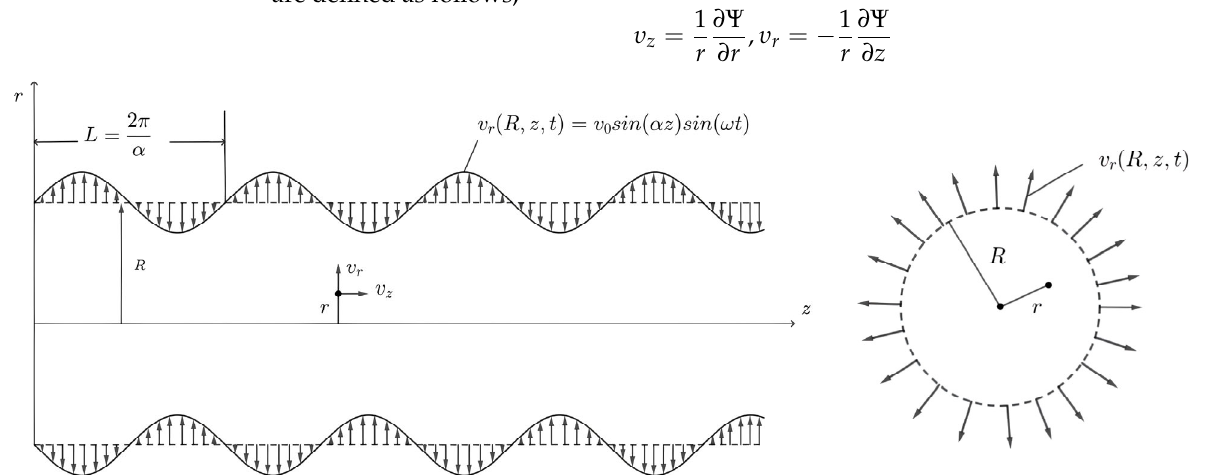
Figure 1. Schematic presentation of the problem. On the left side, the longitudinal cross-section of the pipe with the permeable walls where the suction/injection is represented as a sinusoidal function of z at a given t , with a spatial period of L = 2 π / α . On the right side, the circumferential cross-section of the pipe with a different view of the suction/injection at a given t .